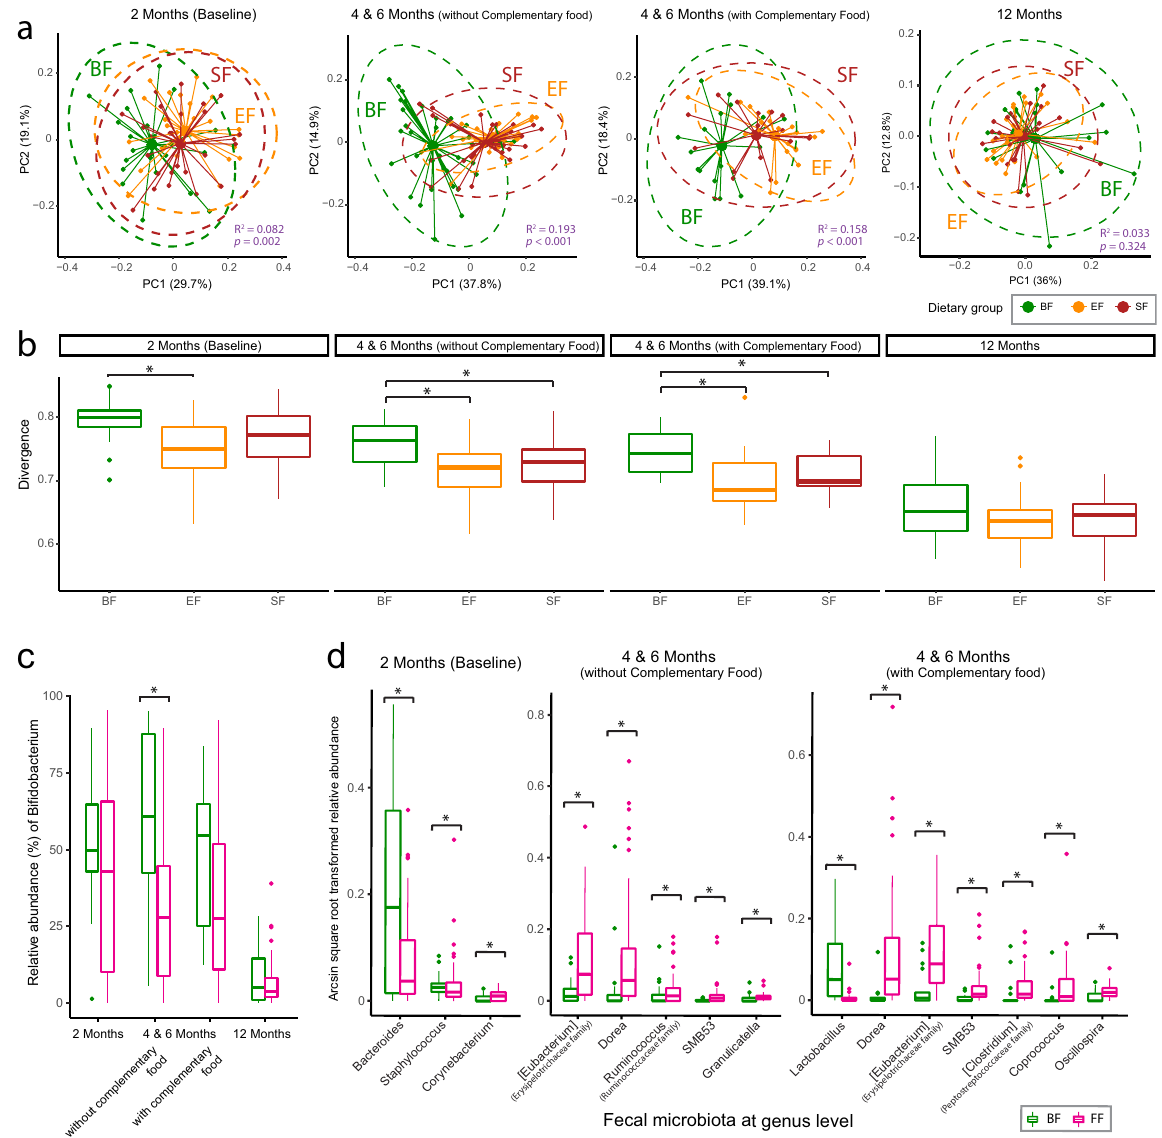
Figure 2. Analysis of the community structure of fecal microbiota reveals differences between breast-fed (BF, green) and formula-fed (Experimental Formula, EF, orange; Standard Formula, SF, red) infants at 2, 4 and 6 months of age. ( a) Principal Coordinates Analysis (PCoA) of the log transformed weighted Unifrac distance. The centroids of each cluster (centroid of mass) are calculated as the average of PC1 and PC2 for each group. The ellipses were constructed based on multivariate normal distribution at 95% confidence level. The effect size (R 2 ) and significance (p-value) between dietary groups were evaluated using permutational MANOVA via the Adonis test (permutation = 999). ( b ) Divergence (the spread within the group) was significantly higher in the BF infants during the exclusive feeding period. The measurement of divergence is calculated as 1- the average spearman correlation between samples and the overall group-wise average. The group difference was evaluated using a Kruskal-Wallis H test follow by the post-hoc Dunn test at p < 0.05. ( c,d) Significantly differentiating intestinal microbes between the breast-fed (BF, green) and formula-fed (FF, pink) infants. The group differences were evaluated using Analysis of Composition of Microbiomes (ANCOM) followed by FDR correction at p <